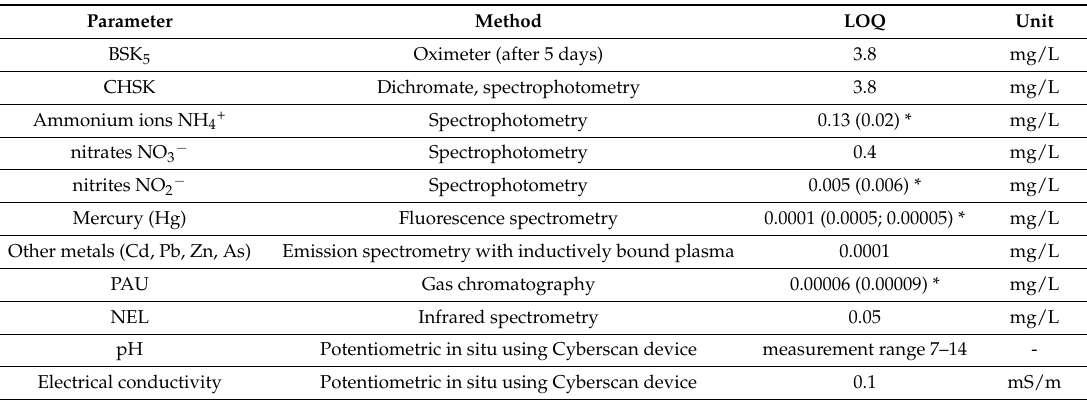
Table 1. Overview of the methodology of determination of the individual sample parameters, including the determination